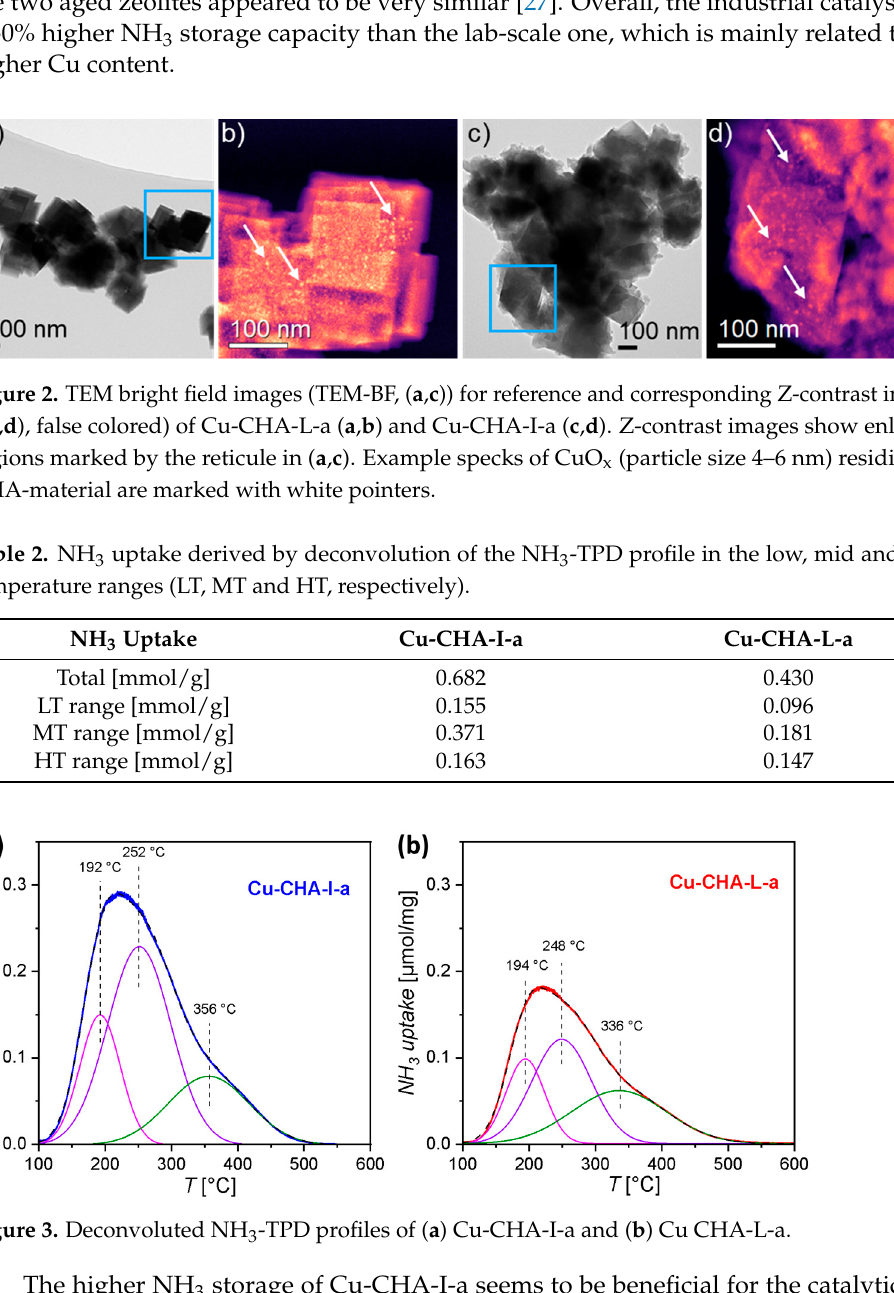
Figure 2. TEM bright field images (TEM-BF, ( a , c )) for reference and corresponding Z-contrast images (( b , d ), false colored) of Cu-CHA-L-a ( a , b ) and Cu-CHA-I-a ( c , d ). Z-contrast images show enlarged regions marked by the reticule in ( a , c ). Example specks of CuO x (particle size 4–6 nm) residing on CHA-material are marked with white pointers.